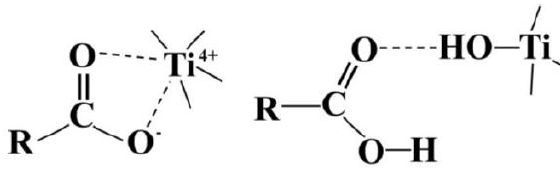
Figure 6. Mechanisms of self-assembly of TiO 2 with a polymer surface. Reproduction from [46].